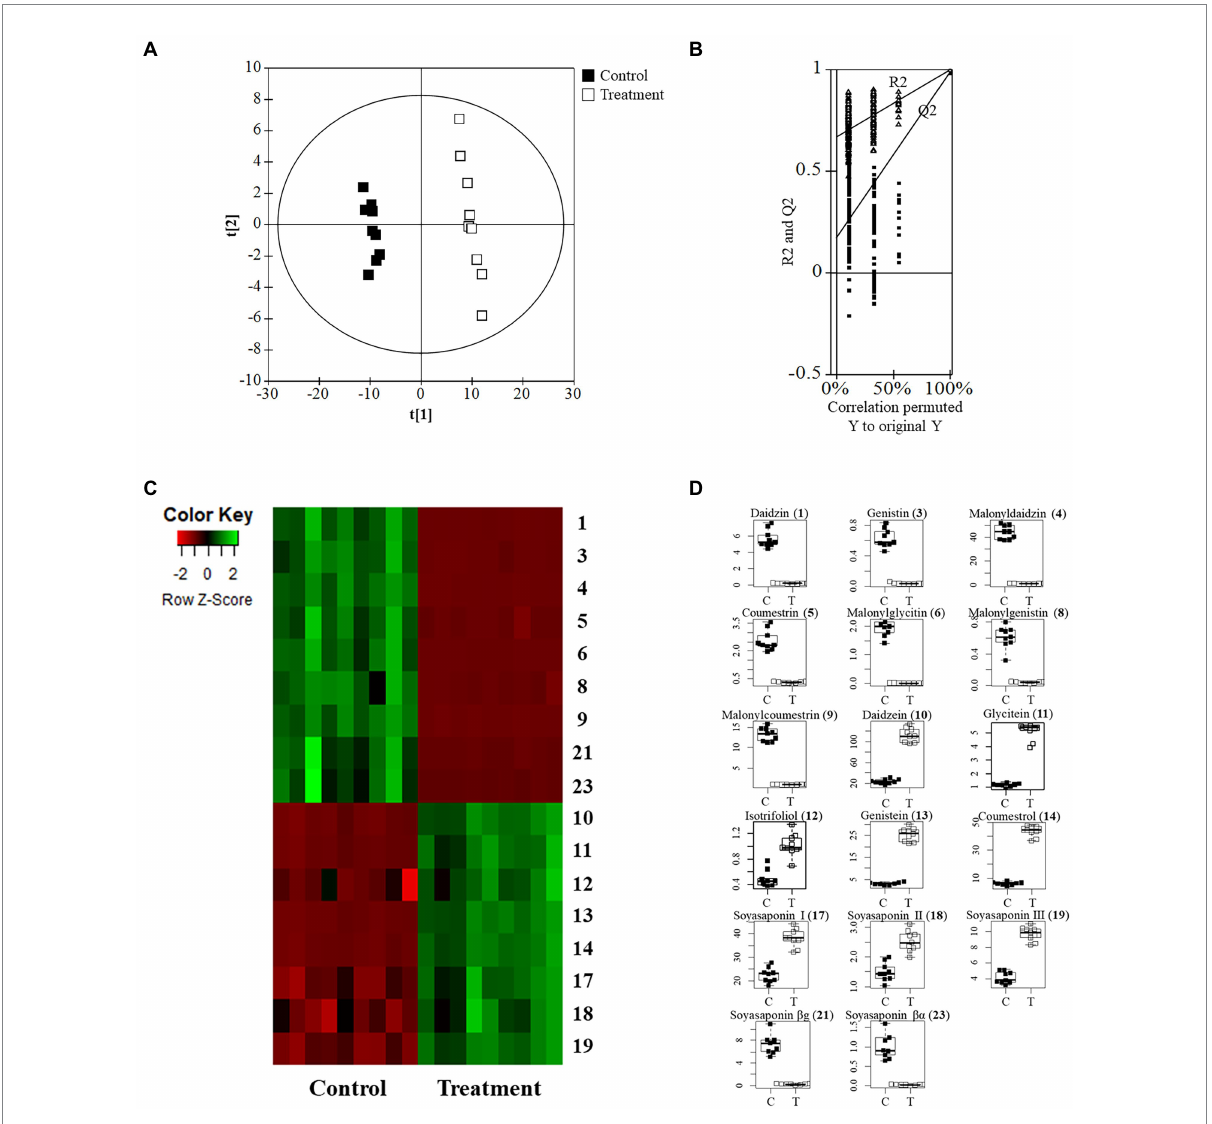
FIGURE 5 Metabolomic analysis of soybean roots by LC-TOF/MS. (A) PLS-DA plots of untreated (control) and SA treated roots. C, control group; T, treatment group. (B) Performance of the permutation tests validated from the PLS-DA model. (C) Heatmap for the 17 metabolites ( p < 0.05) between control and treatment. (D) Boxplots of representative